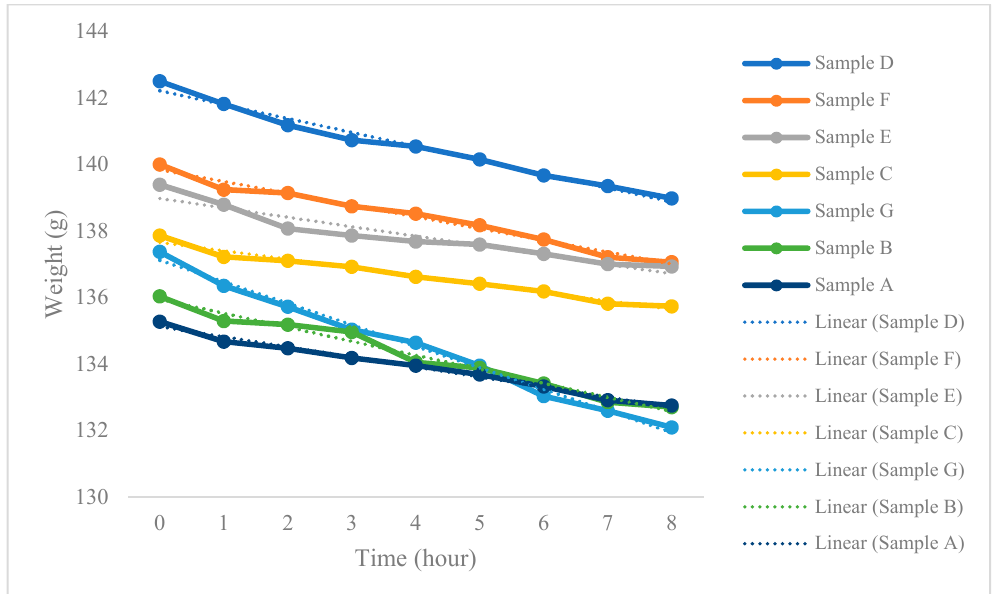
Figure 3. Water vapor transmission of different masks. Note: Water vapor transmission rate (slope): Sample D = − 0.4182; Sample F = − 0.3537; Sample E = − 0.2833; Sample C = − 0.2517; Sample G = − 0.6477; Sample B = − 0.421; Sample A = − 0.3027.